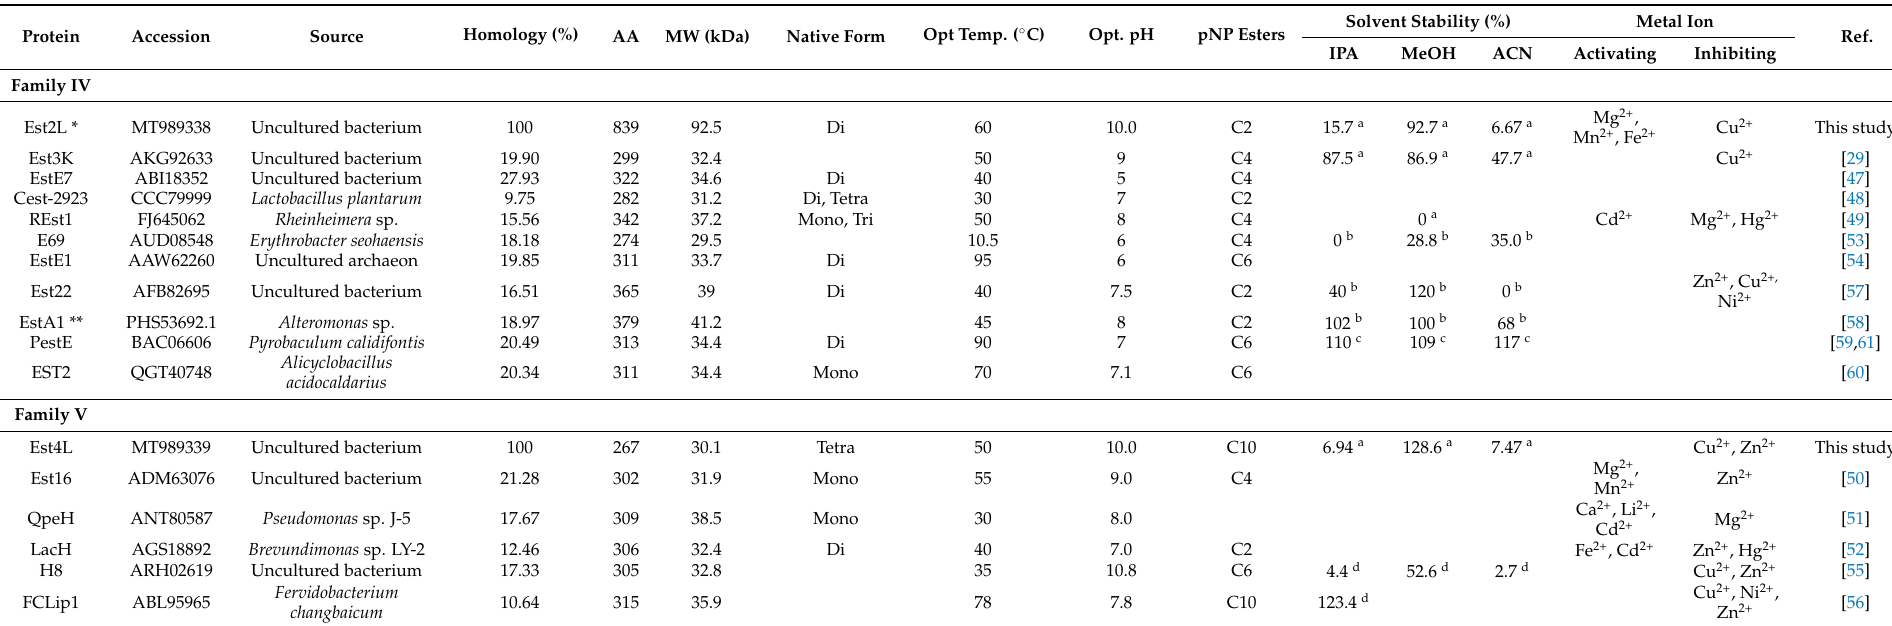
Table 3. Comparison of Est2L and Est4L with other